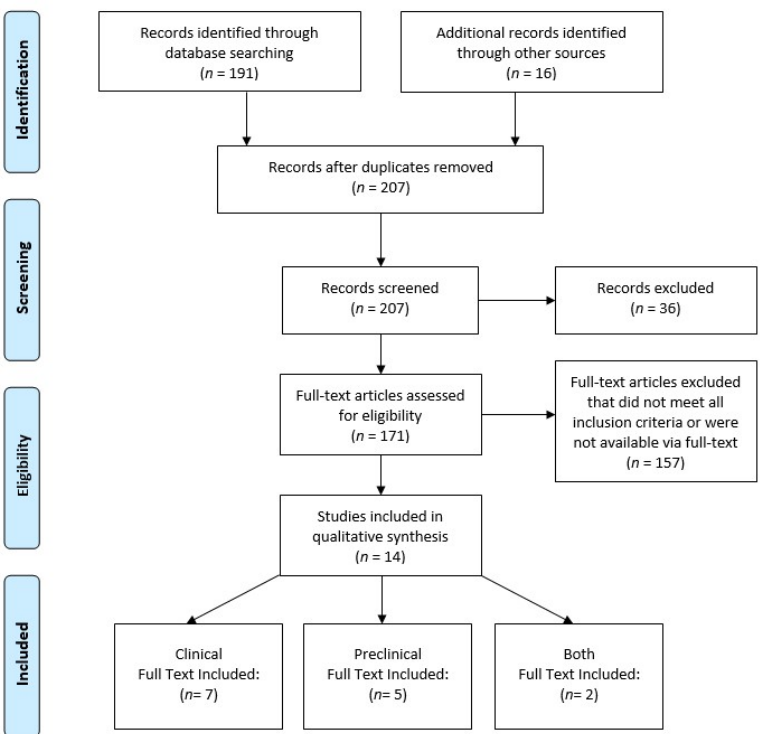
Figure 1. PRISMA flow chart showing the study selection paradigm. The additional sources used for record identification were obtained from bibliography screening of identified articles and appli ‐ cable reviews. The database screening produced unique records and no duplicates were found. PRISMA diagram modified from Moher et al.